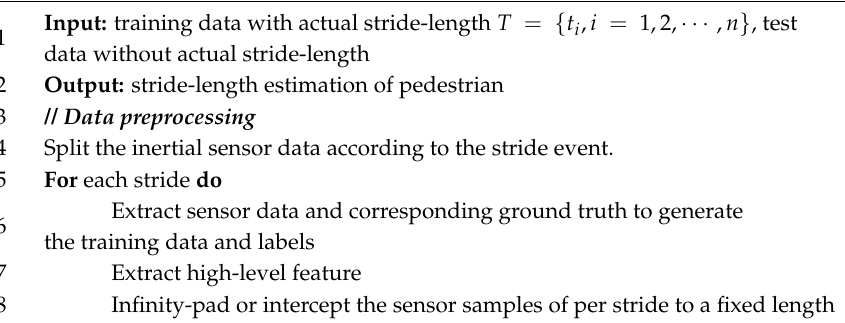
Figure 9. The architecture and parameters of final regression model. Algorithm 1. adaptive stride-length estimation based on LSTM-DAE